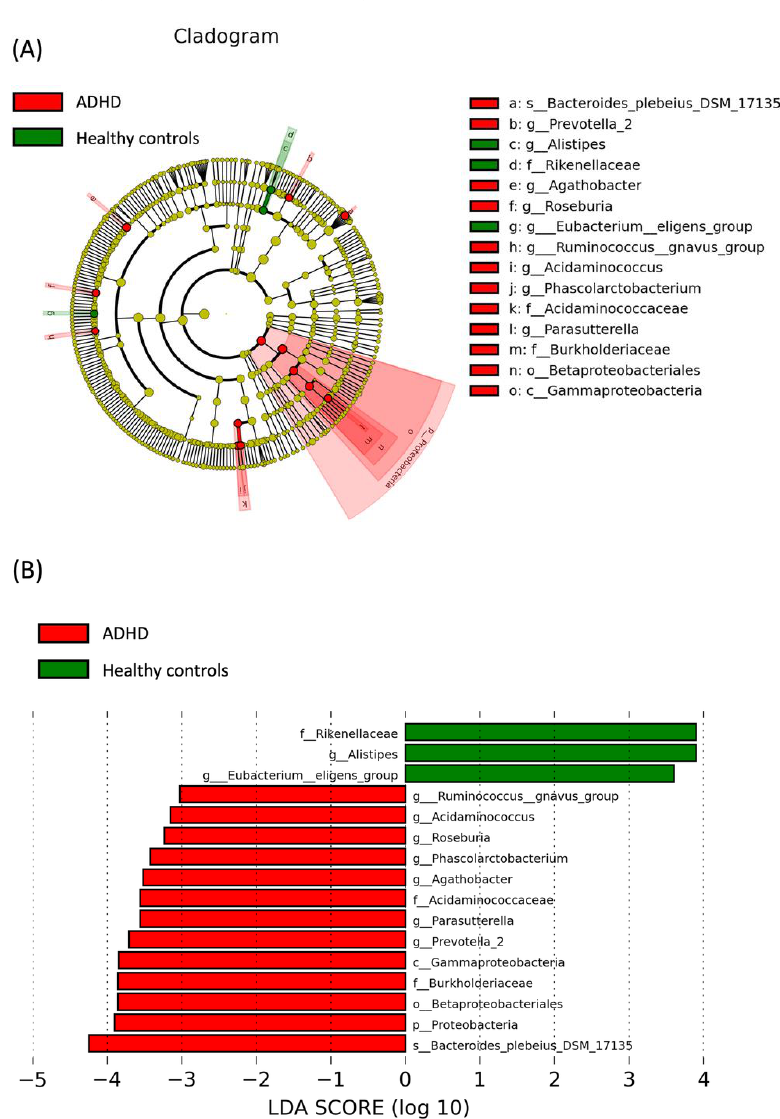
Figure 4. Linear discriminant effect size (LEfSe) analysis. Comparison of microbiota relative abundance at the genus level between ADHD children with treatment-naïve and healthy controls using LEfSe cladograms ( A ) and histogram of linear discriminant analysis (LDA, B ). The bacterial difference was identified by Kruskal-Wallis test. Nominal significant threshold: p < 0.05.